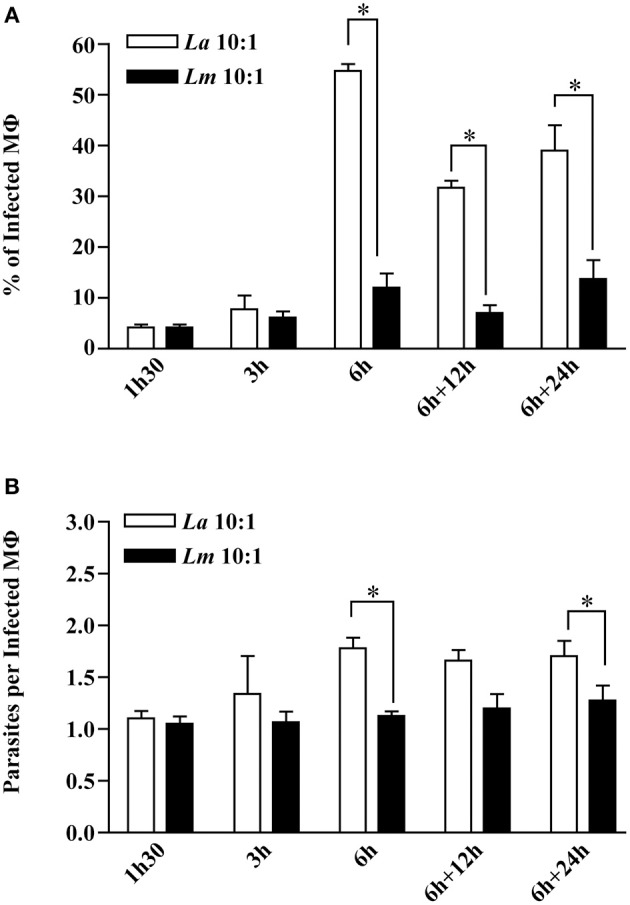
Kinetics of CBA BMMØ infection by L. amazonensis or L. major. BMMØ were infected as described under Materials and Methods. Cells were fixed and then DAPI-stained after 1.5, 3, or 6 h. Additionally, other cells infected for 6 h were washed and re-incubated for an additional 12 or 24 h. (A) Percentage of infected BMMØ and (B) amastigotes per macrophage were quantified by fluorescent microscopy. Statistical differences were evaluated using the Mann-Whitney test (*p < 0.05). Data represent means ± SE of three independent experiments.